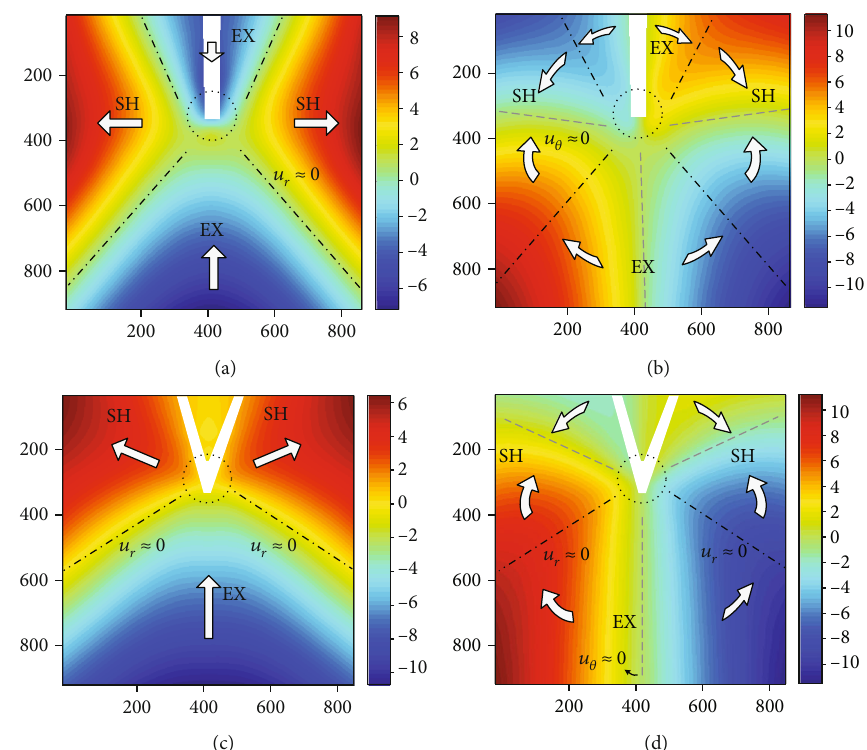
Figure 3: Displacement fi elds near the pinhole area of tensile bionic skin: (a) radial displacement of I-shape suturing; (b) circumferential displacement of I-shape suturing; (c) radial displacement of V-shape suturing; (d) circumferential displacement of V-shape suturing. Units: